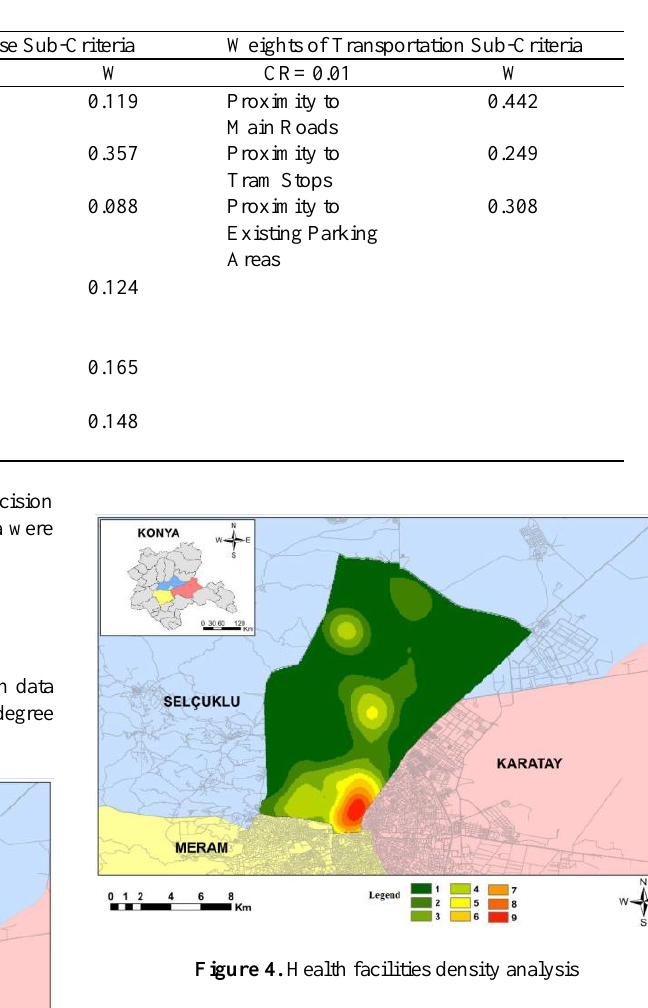
Table 3 . Weights of criteria